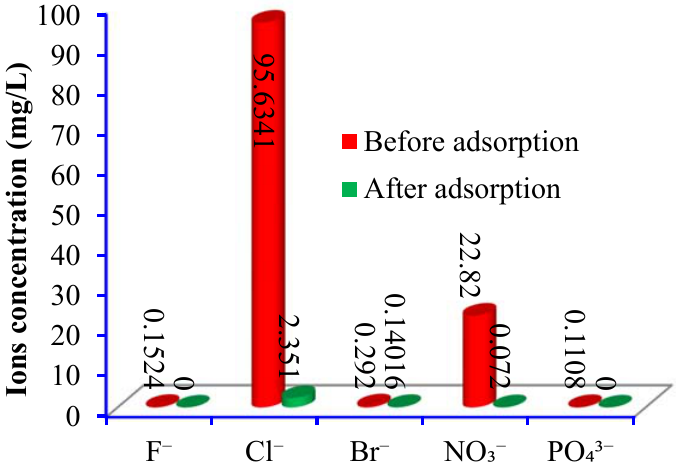
Figure 11. Groundwater decontamination properties of the PANI/GO@GTW. Table 3. Comparison of the adsorption capacities of various materials for Br −